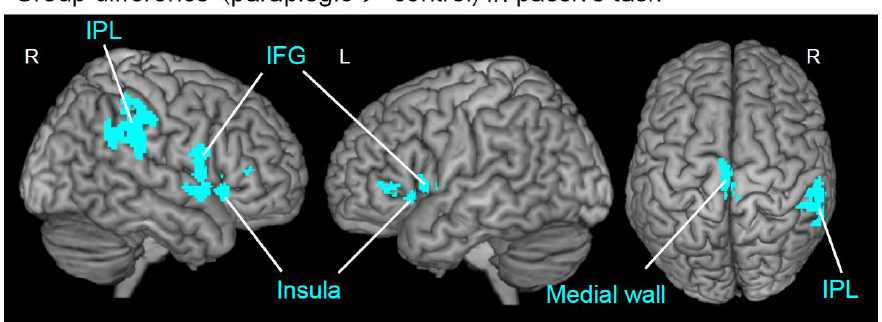
Figure 2. Results from whole brain analysis. Brain regions (cyan sections) showing significant group difference during the passive task are superimposed on the MNI brain. The paraplegic group showed significant clusters of voxels having greater activity in the left medial-wall motor region, right IPL, bilateral IFG, and insula than the control group. The right hemisphere, left hemisphere, and top view are shown in each panel. Abbreviations: R, right; L, left; IPL, inferior parietal lobule; IFG, inferior frontal gyrus; MNI, Montreal Neurological Institute.